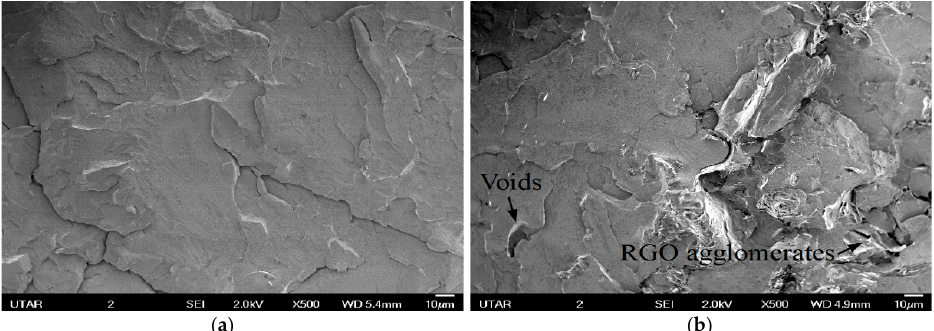
Figure 11. Tensile fracture surfaces of nanocomposites prepared by in situ polymerization with ( a ) 0.5 wt % RGO loading; ( b ) 2.0 wt % RGO loading.